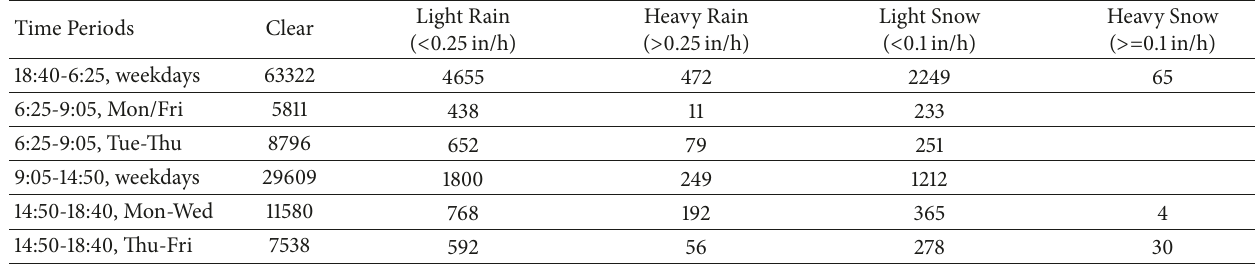
Table 1: Number of travel time samples under different weather